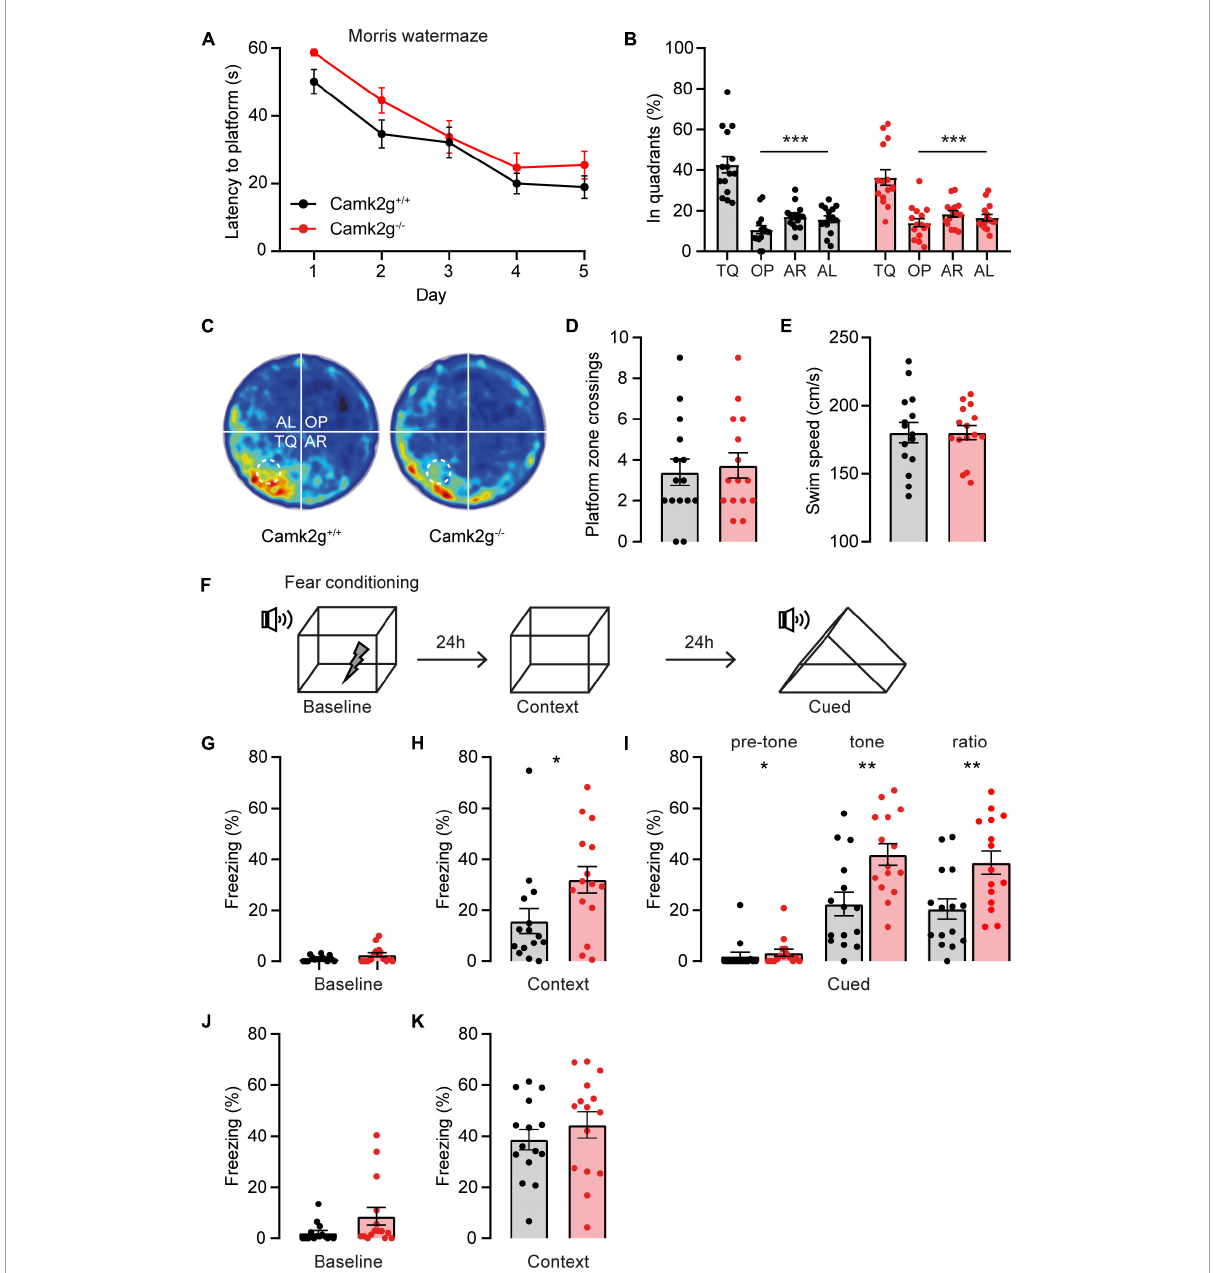
FIGURE2 CAMK2G in cognitive behavior. (A) Camk2g + / + and Camk2g − / − mice similarly showed reduced latencies to find the platform over days [two-way repeated measures ANOVA; interaction: F ( 4 , 112 ) = 0.41, p = 0.804]. (B) Both groups spent significantly more time in the target quadrant (TQ) compared with other quadrants in the probe trial on day 5 [one-way ANOVA with Bonferroni’s post hoc analysis. Camk2 + / + : F ( 3 , 56 ) = 31.61, p < 0.001, TQ vs. OP p < 0.001, TQ vs. AR p < 0.001, TQ vs. AL p < 0.001; Camk2 − / − : itF ( 3 , 56 ) = 17.04, p < 0.001, TQ vs. OP p < 0.001, TQ vs. AR p < 0.001, TQ vs. AL p < 0.001]. TQ, target quadrant; OP, opposite; AR, adjacent right; AL, adjacent left. (C) Heat map of the probe trial, the arena is divided into four quadrants and the location where the platform was located during learning is indicated with a dashed line. (D) During the probe trial, mice crossed the zone where the platform was situated during learning with a similar frequency [unpaired t -test, t ( 28 ) = 0.37, p = 0.711]. (E) Swim speed velocity was similar between groups during the probe trial [unpaired t -test, t ( 28 ) = 0.0018, p = 0.999]. (F) Schematic representation of the fear conditioning test. (G) Freezing behavior at baseline showed no significant difference between Camk2g + / + and Camk2g − / − (Mann–Whitney U test, U = 84.5, p = 0.245). (H) When placed in the same context, Camk2g − / − showed significantly more freezing (Mann–Whitney U test, U = 60, p = 0.030). (I) When put in a different context, Camk2g − / − already showed more freezing than Camk2g + / + pretone (Mann–Whitney U test, U = 64, p = 0.026). Upon exposure to the tone, Camk2g − / − again showed significantly more